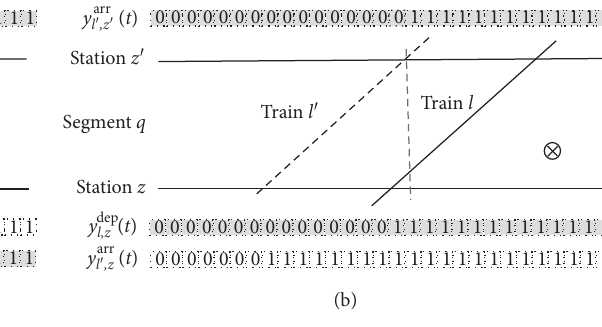
Figure 4: Two trains running at segment under different scenarios: (a) two trains running at segment from opposite direction; (b) two trains running at segment from the same